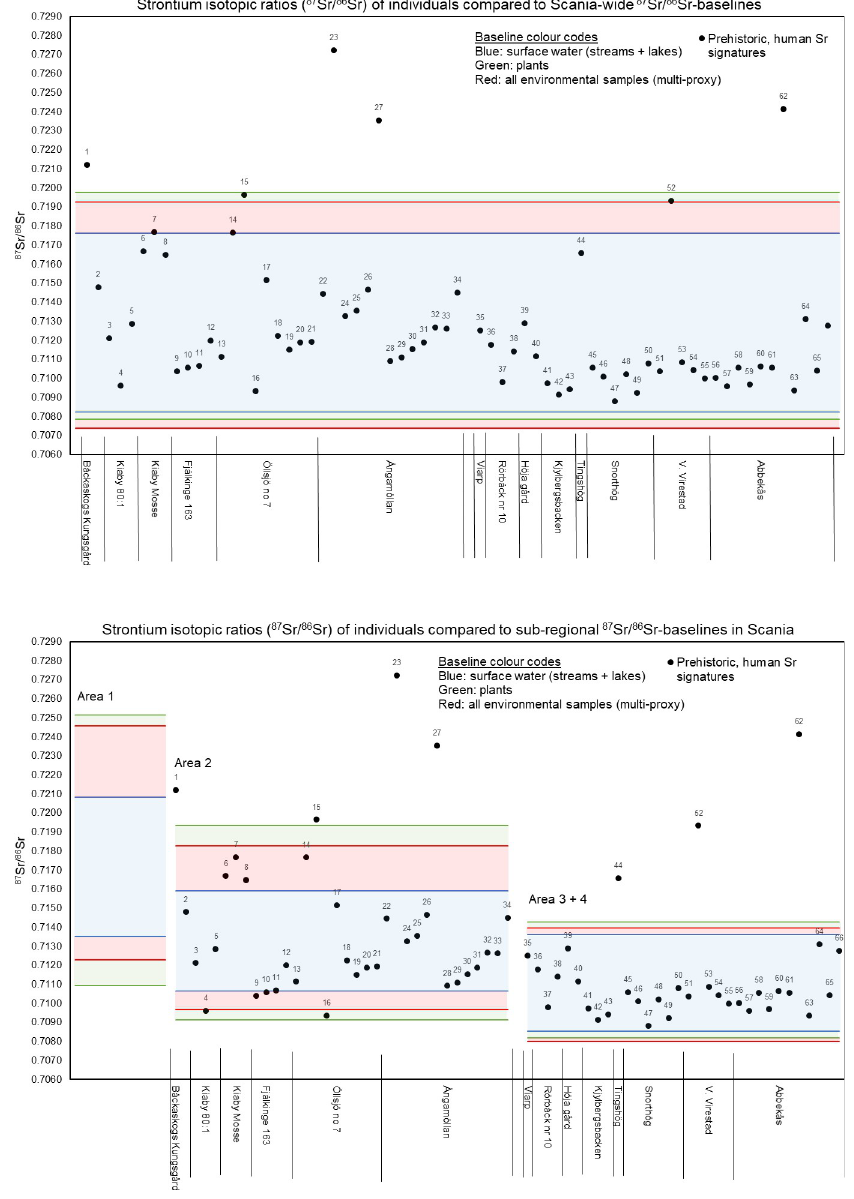
Fig 10. A. Prehistoric human Sr isotope signatures reported in [13], compared to Scania-wide baselines defined by multi-proxy and single-proxy archive data presented herein. Baselines are calculated as means of the measured strontium isotopic range of relevant proxies ± 2 σ . Numbering of samples is successive to ease referencing in text and does not correspond to the original sample labels used in original publication. Five individuals fall outside the Scania- wide multi-proxy baseline using four digit ratios. B. Spatially categorised prehistoric human Sr isotope signatures reported in [13], compared to sub-regional baselines in Scania defined by multi-proxy and single-proxy archive data presented herein. Baselines are calculated as means of the measured strontium isotopic range of relevant proxies ± 2 σ . Numbering of samples is successive to ease referencing in text and does not correspond to the original sample labels used in original publication. While five individuals have Sr isotope signatures outside the Scania-wide multi-proxy baseline (Fig 10A), nine individuals fall outside the sub-regional multi-proxy baselines proposed herein, using ratios with four decimals. No sites lie within Area